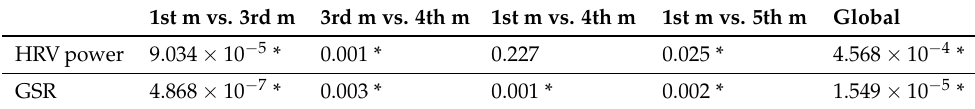
Table 6. Experiment 1 p -values. ( p -value below the threshold of 0.05 is marked using